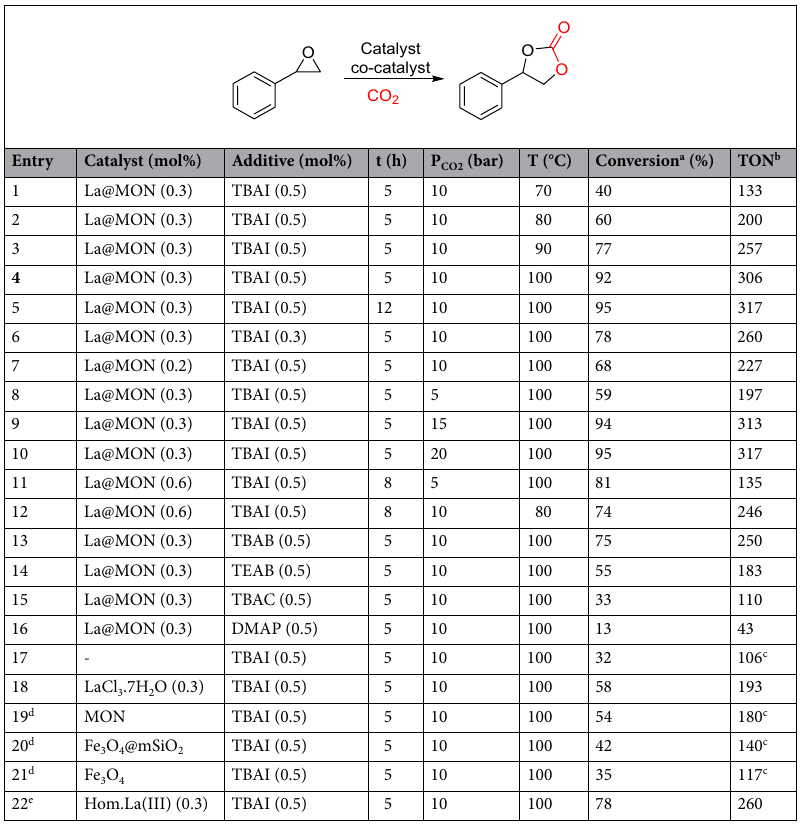
Table 3. Possibility for coupling of CO 2 with styrene oxide under various reaction conditions. Reaction conditions: styrene oxide (5 mmol), La@MON (115 mg, 0.3 mol% La to epoxide), and 10 bar CO 2 unless otherwise specified. a Conversion of styrene oxide determined by GC technique using trimethylbenzene as internal standard. Selectivity for styrene carbonate was consistently above 99% b TON: turnover number calculated by [(mmol of carbonate)/(mmol of La)]. c TON was determined in terms of TBAI. d 115 mg of desired materials were used. e Homogeneous complex of lanthanum(III) catalysts with N-butyl dipicolinic